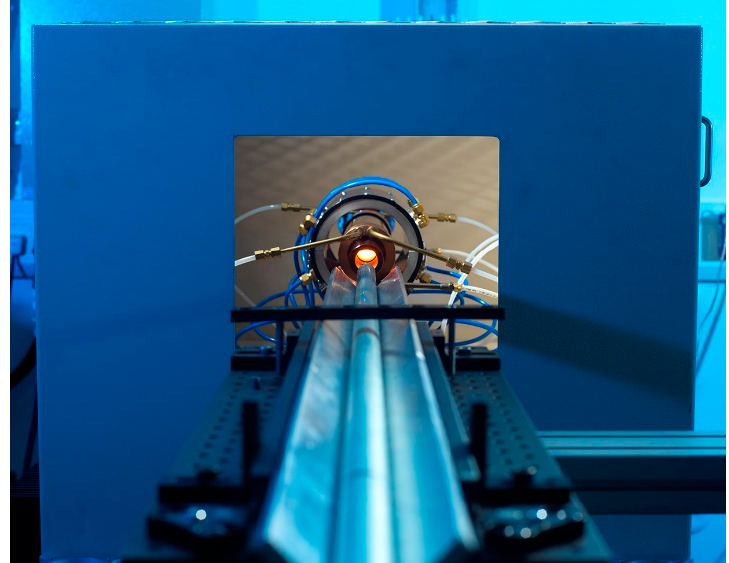
Figure 6. Photograph of the calibration furnace: the instrument sensor, housed in a steel tube, is sitting on the V-groove placed in front of blackbody furnace, ready to be manually moved in and out of it for dynamic calibration at a set temperature.